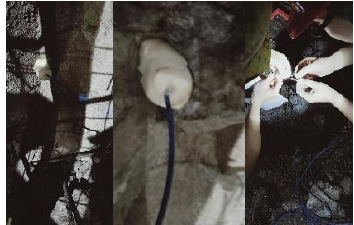
Figure 10. On-site installation and measurement.